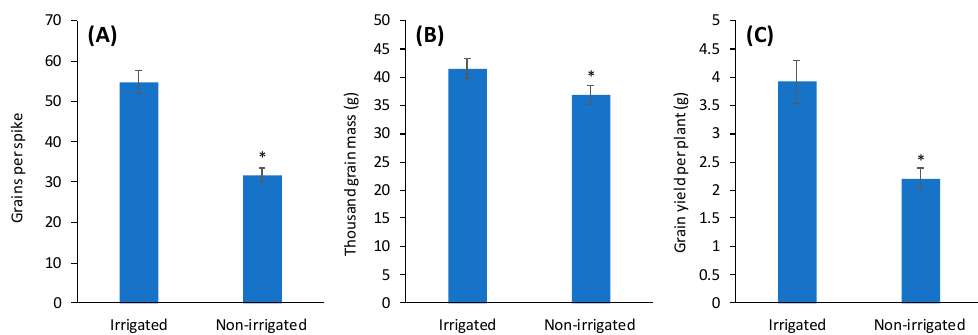
Figure 2. Mean values of studied yield traits for irrigated and non-irrigated variants: ( A ) Average number of grains per spike; ( B ) thousand grain mass; and ( C ) grain yield per plant. The mean values ± standard error of 25 genotypes, 4 repetitions per genotype ( n = 100) are presented. An asterisk indicates significant di ff erences between non-irrigated and irrigated variants (Tukey HSD post hoc tests, p < 0.05).